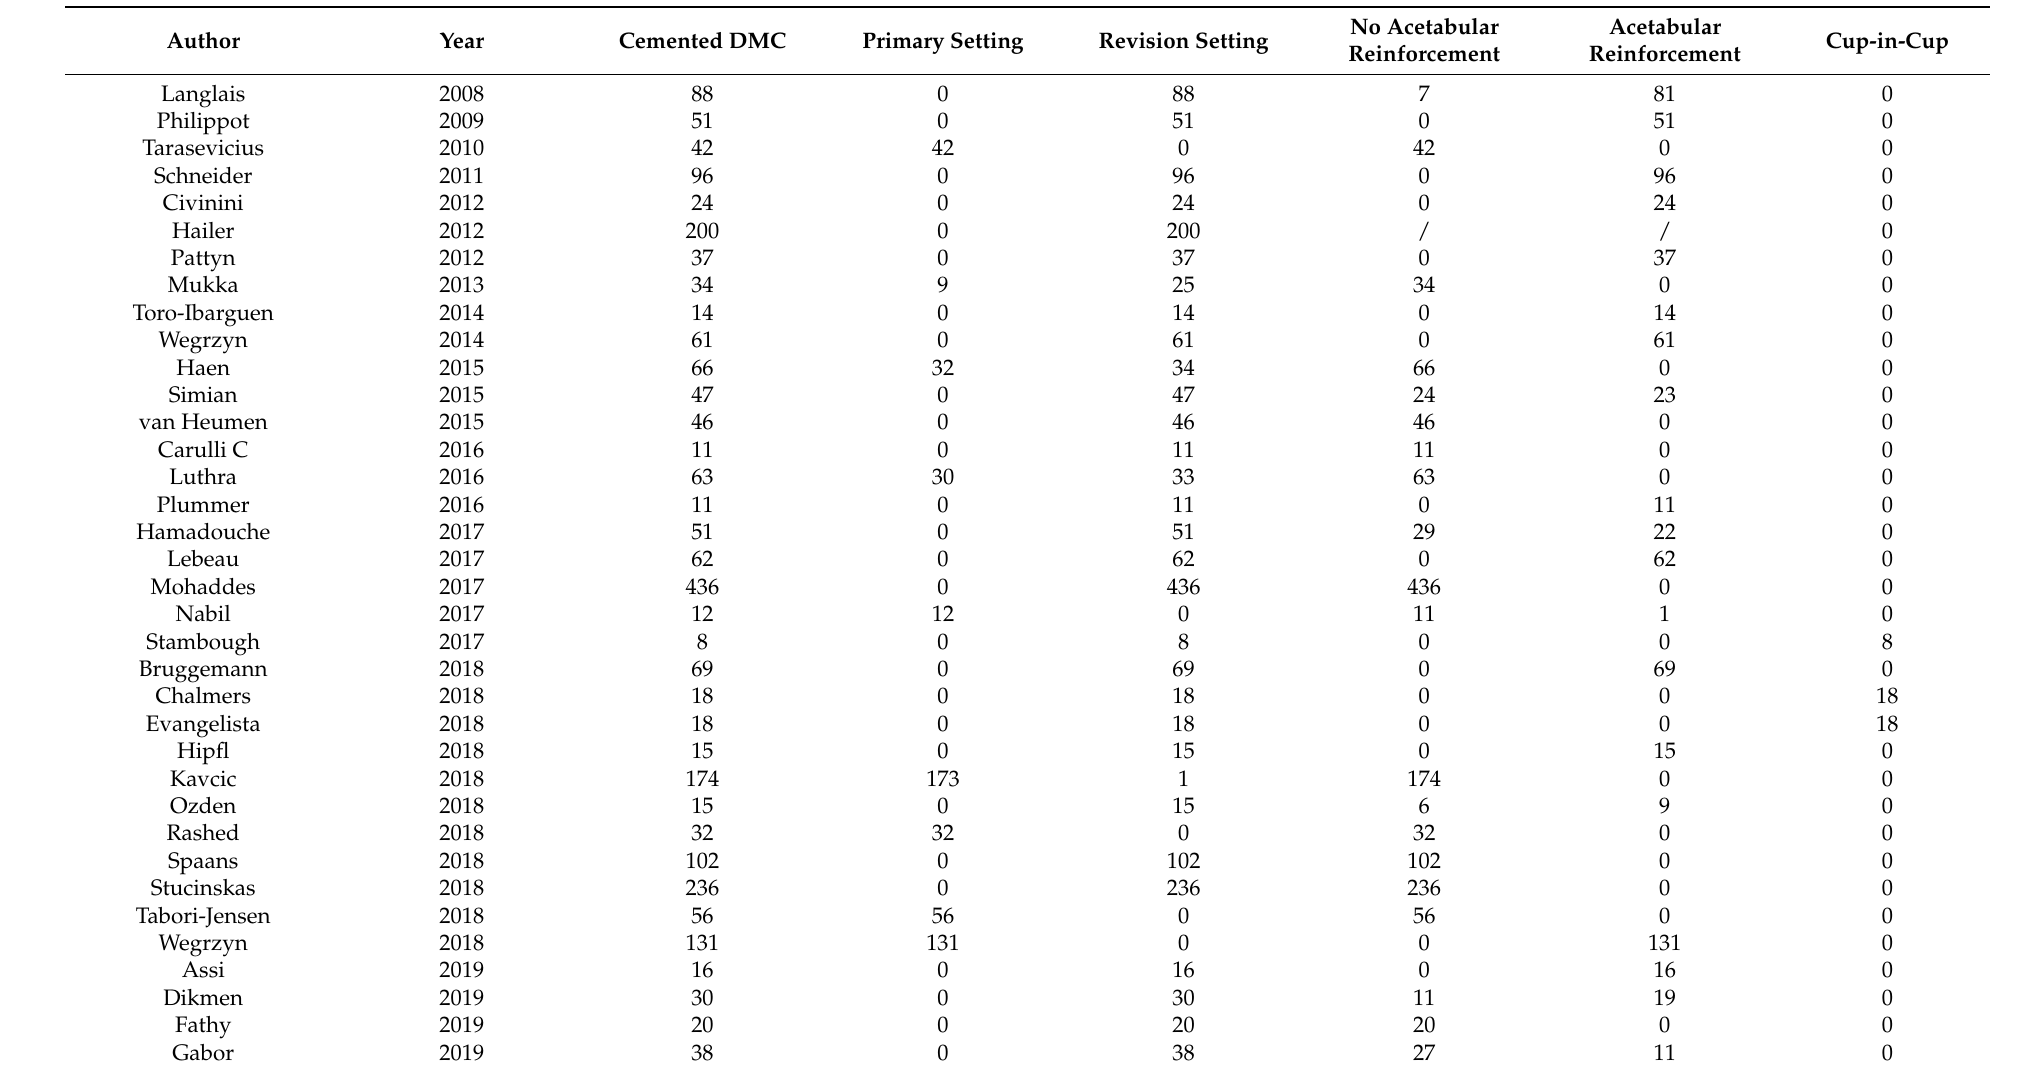
Table 3. Cemented dual mobility cup: surgical